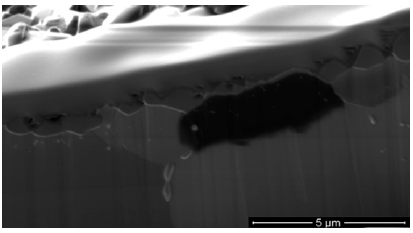
Figure 15. SEM image of oxide complex formed on the Inconel 625 surface. The top layer is shown on Image is a carbon coat protection layer for the ion milling process (20,000×).